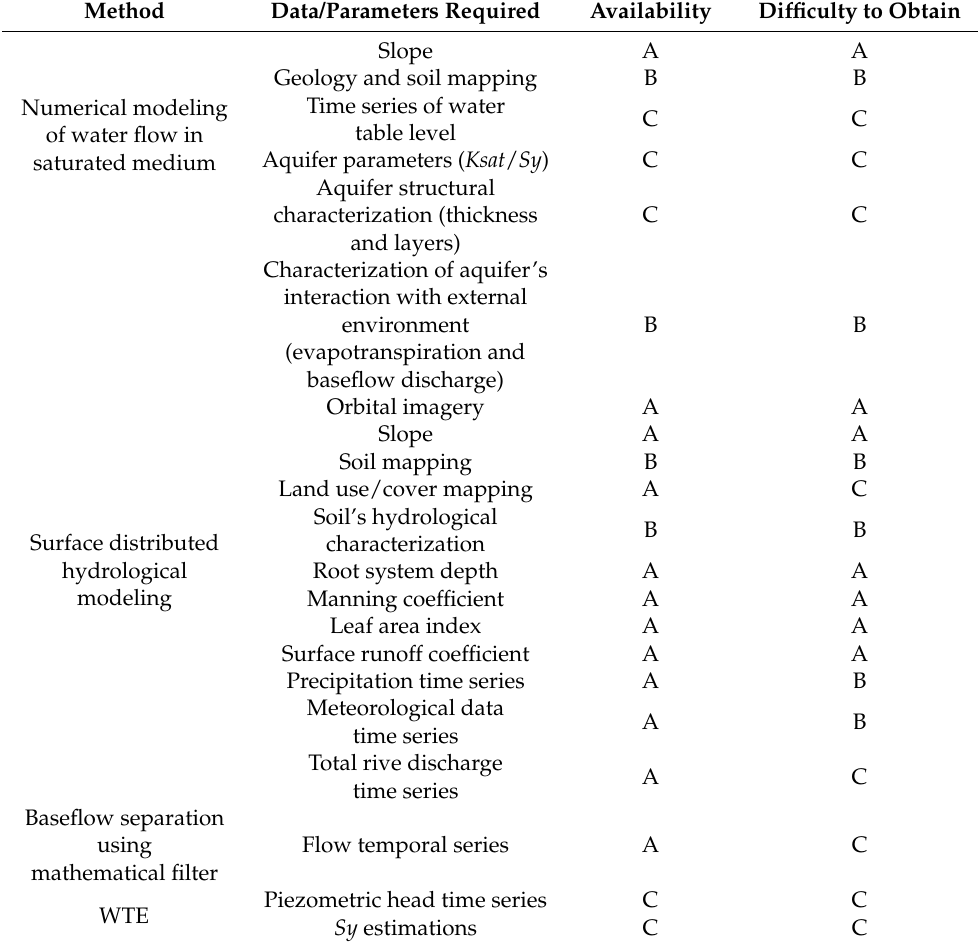
Table 8. Methods and data required for groundwater recharge assessment. (Availability: 1 = frequent; 2 = regular; 3 = rare; Difficulty to obtain: A = low; B = medium; C =